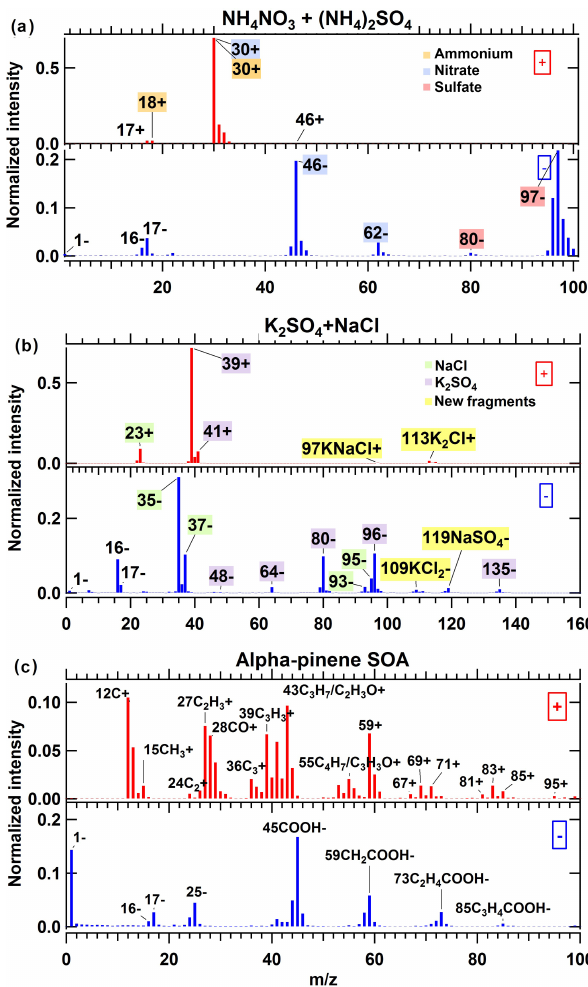
Figure 4. Average mass spectra for particles of internal mixtures of (a) NH 4 NO 3 and (NH 4 ) 2 SO 4 ( d va = 1102nm), 454 single spec- tra averaged, and (b) NaCl and K 2 SO 4 ( d va = 1375nm), 259 single spectra averaged, as well as (c) secondary organic aerosol (SOA) particles from α -pinene ozonolysis, which was performed in the APC chamber, and then the resulting particles were transferred into the AIDA chamber at 263K and 95% RH, d va = 505nm, 1938 sin- gle spectra averaged. In (a) , red, blue, and orange label shadings represent fragments of sulfate, nitrate, and ammonium, respectively. In (b) , green and purple label shadings represent fragments from NaCl and K 2 SO 4 components (see Sect. 3.2.1) in the mixed par- ticles, respectively; yellow label shadings represent the fragments only in the internal mixture of NaCl and K 2 SO 4 .